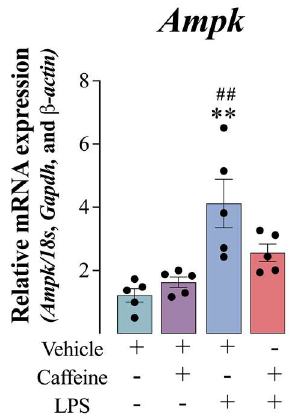
Figure 5. Caffeine administration reverted the catabolic effect induced by the administration of lipopolysaccharide (LPS) in the vastus lateralis muscle of mice. Adult Swiss male mice (3–5 months of age; body mass 45–50 g) received a single intraperitoneal (i.p.) injection of caffeine and/or LPS (See Materials and Methods for details). Ampk gene expression raw data were normalized by the average of the Ct of the 18s , Gapdh and β - actin genes and calculated by the method (2 − ∆ Ct ). Bars represent the mean ± standard error of the mean of five independent experiments (animals) performed in technical duplicates. ** p < 0.01 vs. vehicle; ## p < 0.01 vs. caffeine. Two-way ANOVA followed by Tukey’s test.